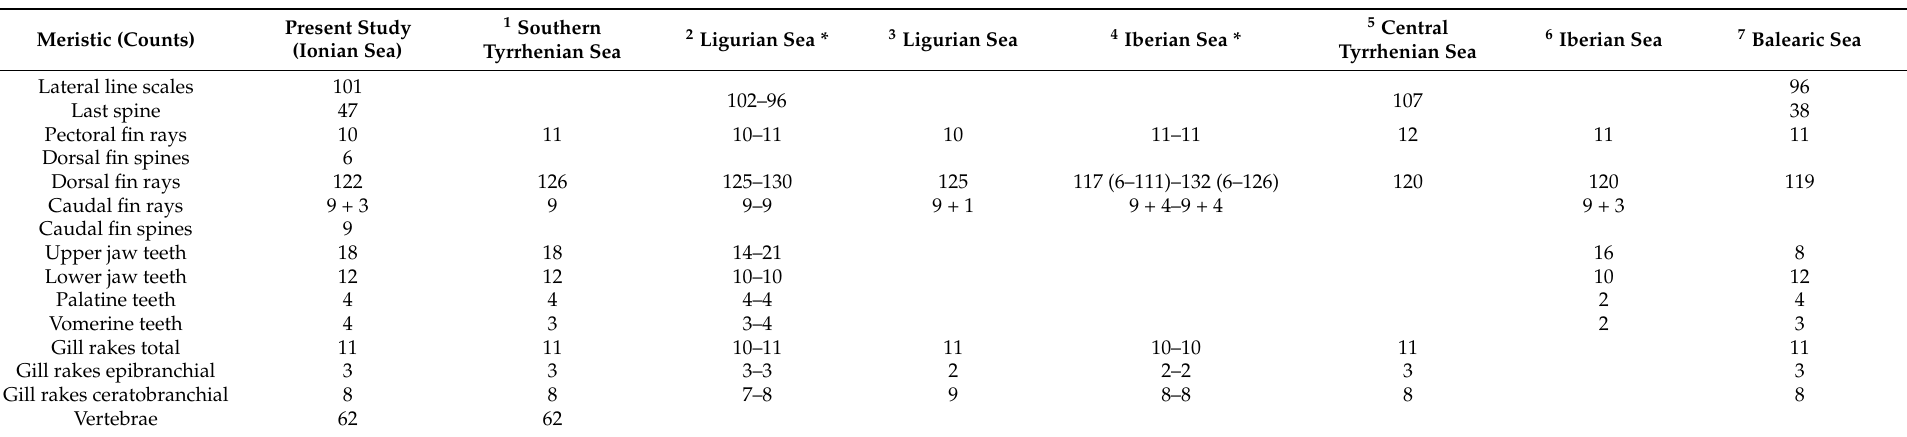
Table 2. Meristic data of the specimen of this study. compared with some Z. cristatus specimens reported with details in the Mediterranean area. 1 Falsone et al. 2017; 2 Psomadakis et al. 2007; 3 Tortonese. 1958; 4 Roig & Demestre. 1982; 5 Bianco et al. 2006; 6 Ibanez & Gallego. 1974; 7 Garcia-Barcelona et al. 2014. * Identify the studies with two described specimens. The first column numbers were all referred to the specimens 1 reported in the study; the second column numbers were all referred to specimens 2 reported in the